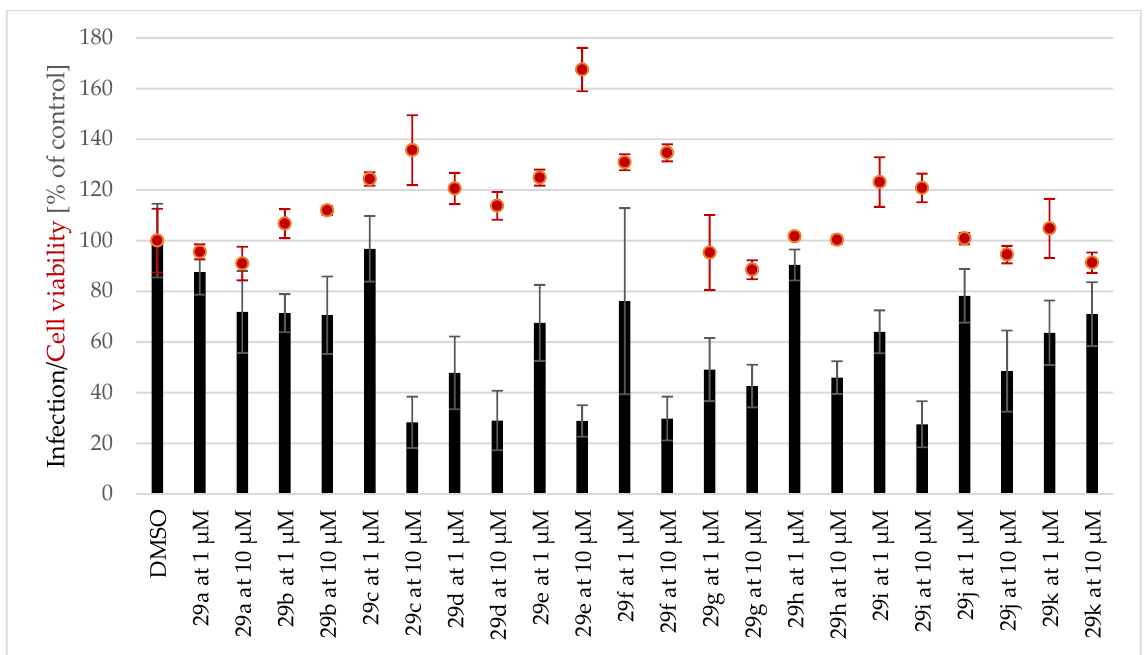
Figure 5 . Screening of inhibitory activity of haemanthamine derivatives against the hepatic stage of Plasmodium berghei in Huh-7 cell line .